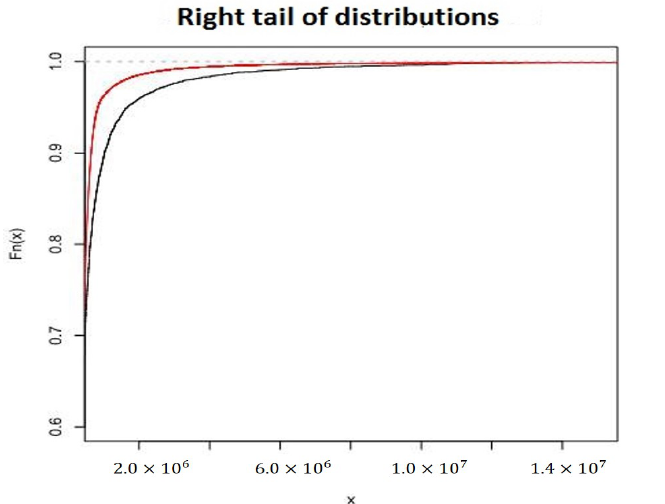
Figure 3. Right tails of Lognormal–KumPareto (red line) and empirical distribution (dark line) functions.